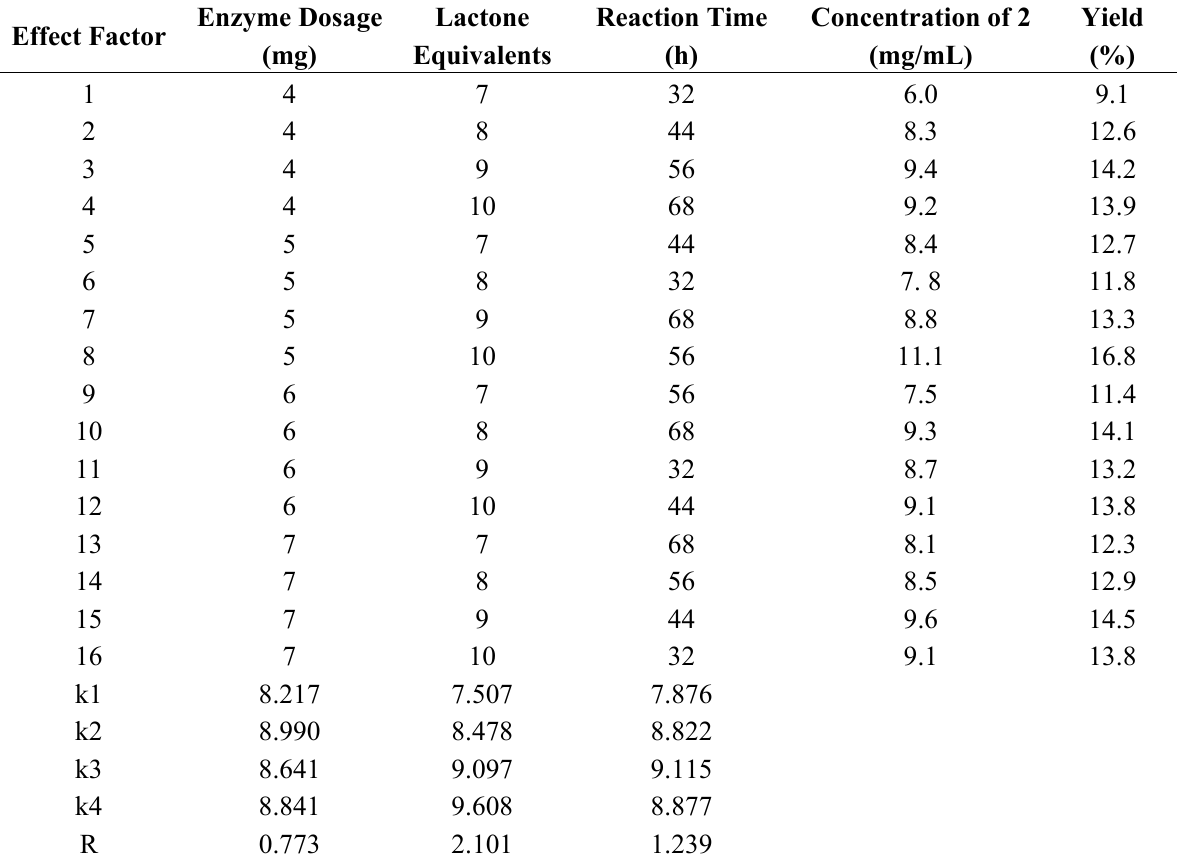
Table 1. Orthogonal experiment to determine the optimal enzymatic reaction conditions of 2 . Effect